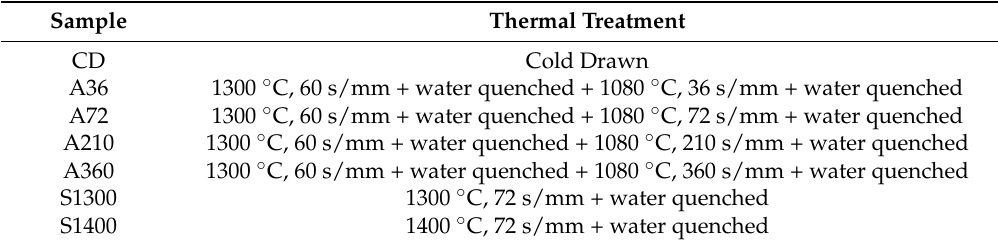
Table 1. Summary of the performed thermal